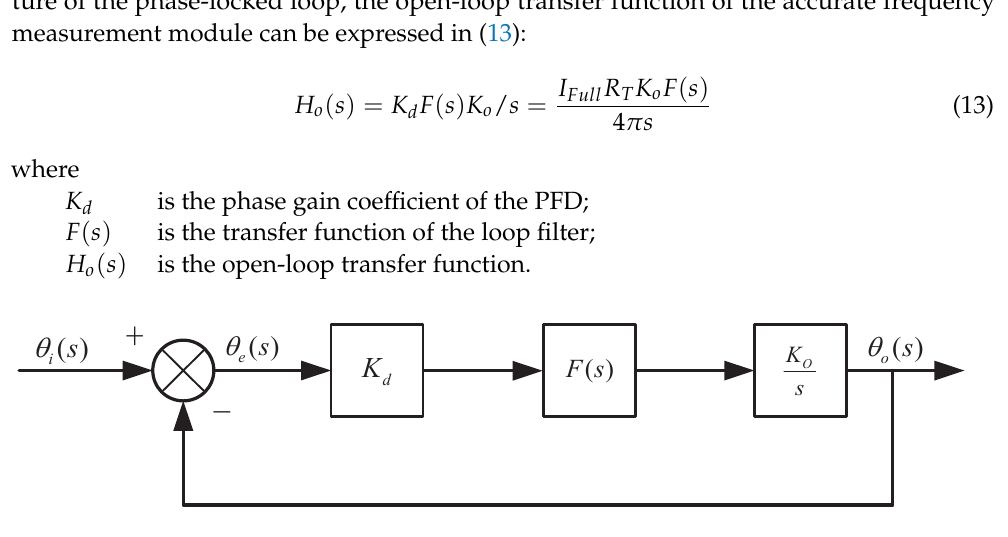
Figure 9. The simplified mathematical structure of the phase-transfer